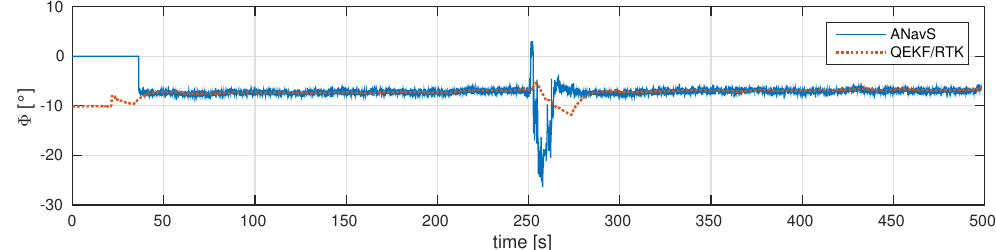
Figure 4. Static evaluation: the ANavS reference heading and the result of the proposed method.